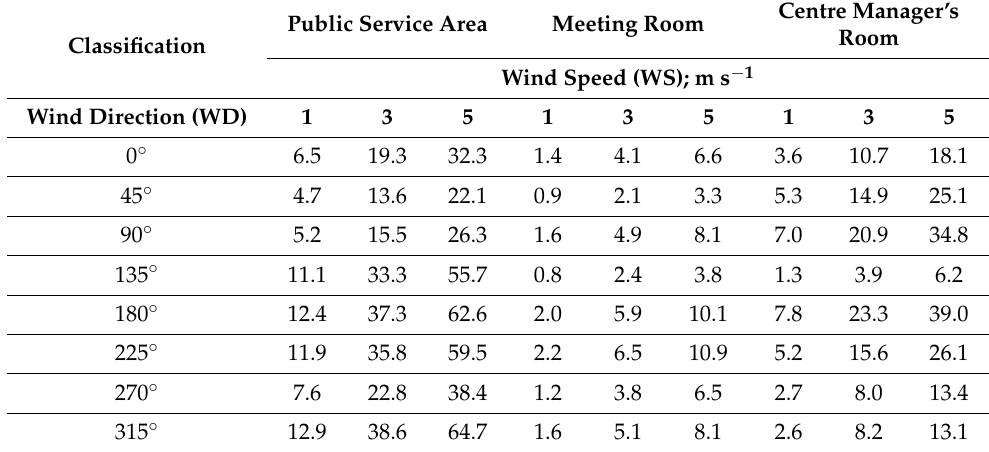
Table 6. MFR ventilation inside the office building according to WD and WS (unit: ACH).